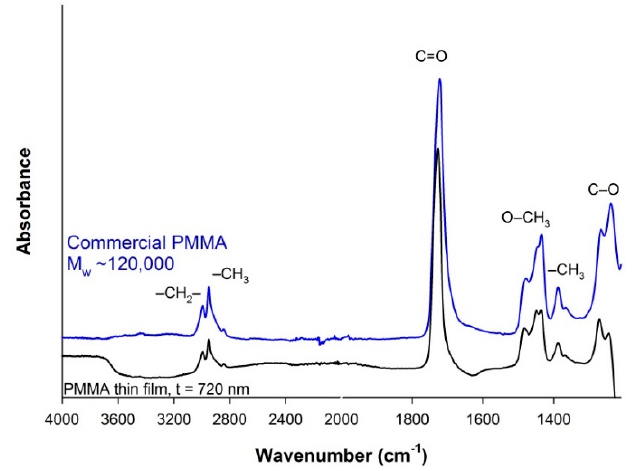
Figure 5. FTIR spectra of bulk PMMA and spin-cast film collected in ATR mode with a diamond crystal. The thin film was not removed from the glass substrate prior to measuring spectra, which limited the spectral range to 1200 cm − 1 due to the strong silicate absorbance from the glass substrate.